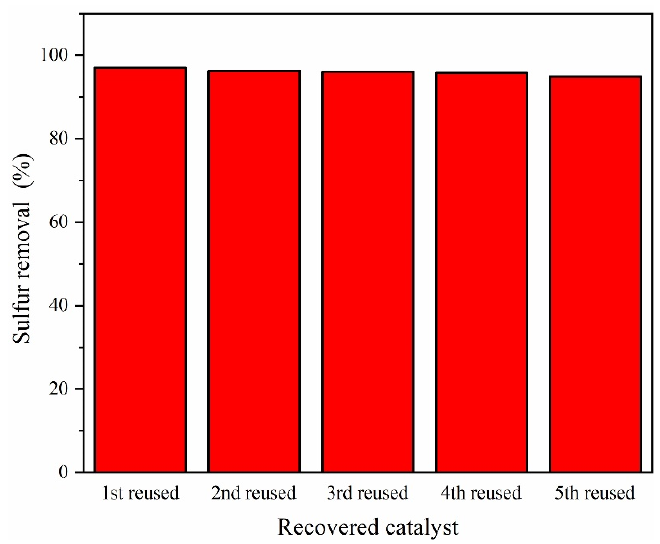
Figure 11. The ODS performance of the reused catalyst.